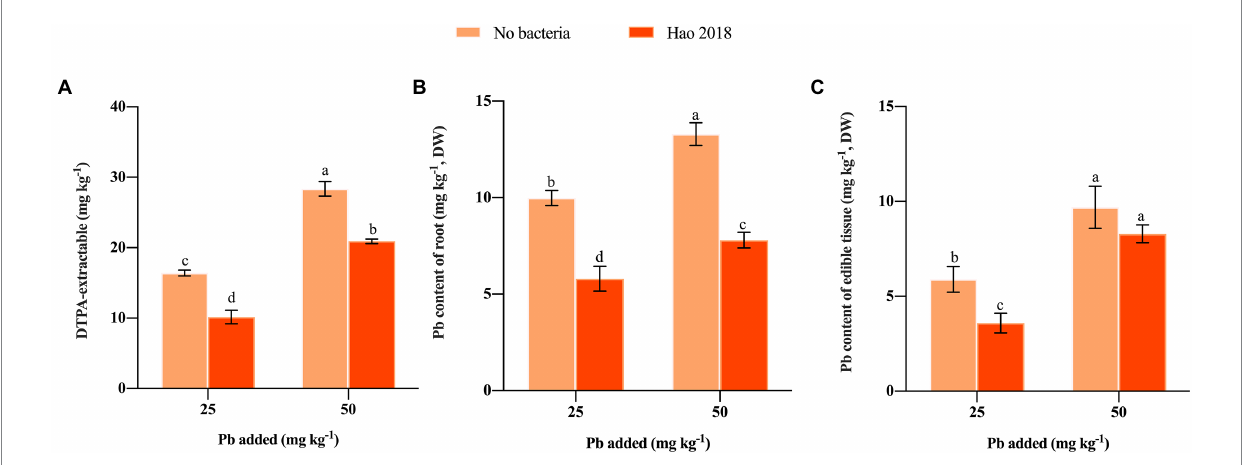
FIGURE 2 The influence of Hao 2018 on DTPA-extractable Pb content (A) Pb content of the root (B) and Pb content of the edible tissues (C) in the rhizospheric soil of pakchoi. Each bar represents the mean ± SD ( n = 4). Bars marked with the same letter within each treatment are not significantly different ( p >